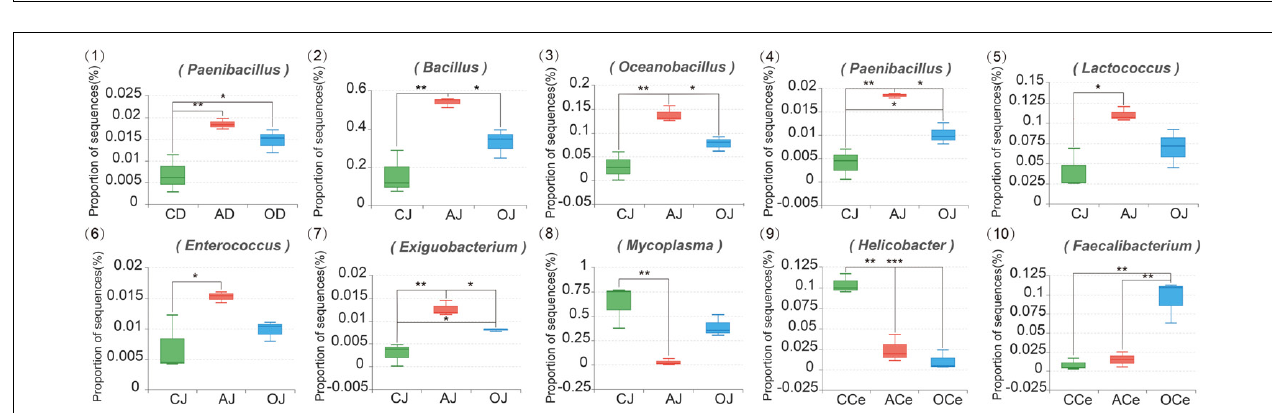
FIGURE 3 | The Composition Analysis of Microbiota Community at the Phyla Level. (A) Duodenum samples. (B) Jejunum samples. (C) Ileum samples. (D) Cecum samples. (E) Colon samples. (F) Feces samples. CD, AD, and OD: duodenum mucosal microbiota of control group, alfalfa meal group and commodity concentrated fiber group, respectively. CJ, AJ, and OJ: jejunum mucosal microbiota of control group, alfalfa meal group and commodity concentrated fiber group, respectively. CI, AI, and OI: ileum mucosal microbiota of control group, alfalfa meal group and commodity concentrated fiber group, respectively. CCe, ACe, and OCe: cecum mucosal microbiota of control group, alfalfa meal group and commodity concentrated fiber group, respectively. CCo, ACo, and OCo: colon mucosal microbiota of control group, alfalfa meal group and commodity concentrated fiber group, respectively. CF, AF, and OF: feces mucosal microbiota of control group, alfalfa meal group and commodity concentrated fiber group, respectively. ∗ 0.01 < P < = 0.05, ∗∗ 0.001 < P < = 0.01, ∗∗∗ P < = 0.001.